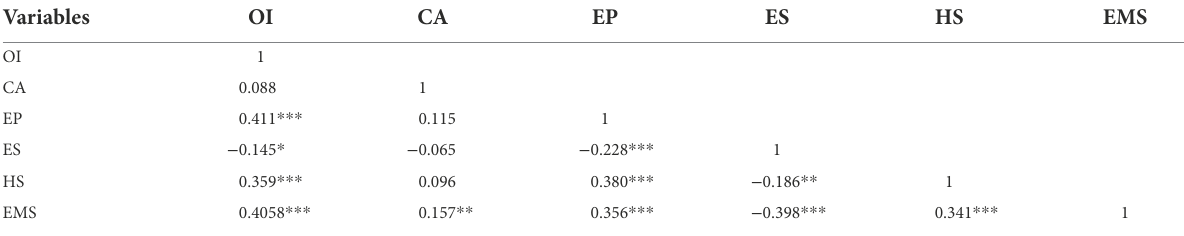
TABLE 5 Correlation matrix.